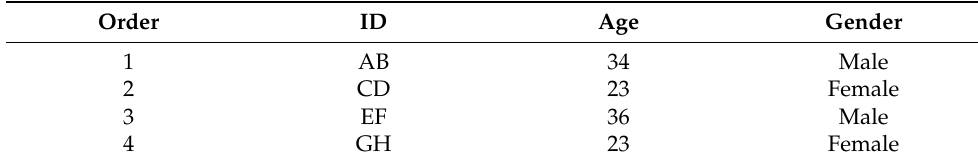
Table 4. Local dataset